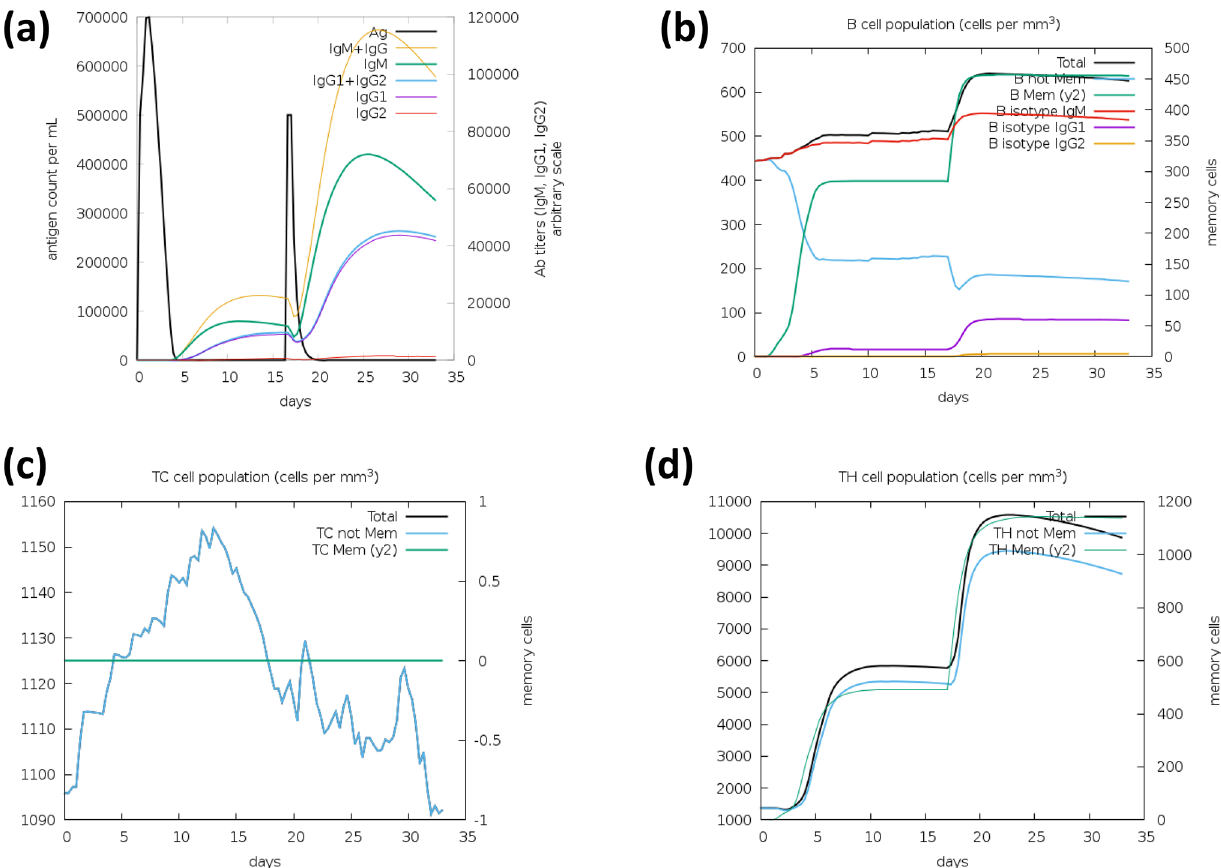
Figure 6. Immune simulation results from C-IMMSIM of the vaccine construct showing immune response through ( a ) production of immunoglobulin in response to antigen injections (black vertical lines) and ( b ) B lymphocytes: total count, memory cells, and sub-divided in isotypes IgM, IgG1 and IgG2 ( c ) CD8 + T-cytotoxic lymphocytes count ( d ) CD4 + T-helper lymphocytes